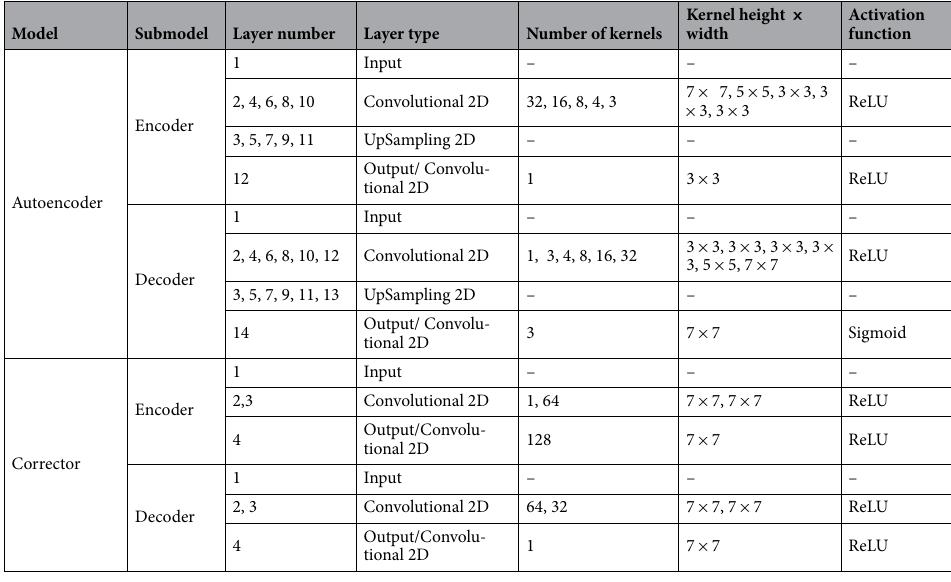
Table 1. Architecture description of the models built using TensorFlow-Keras, the autoencoder and corrector